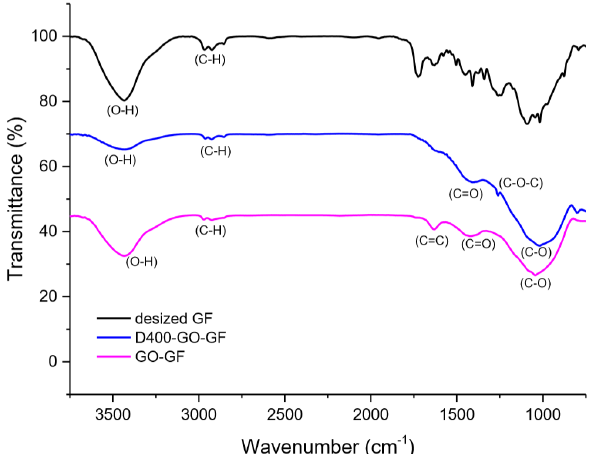
Figure 7: FTIR-spectra of three kinds of GF